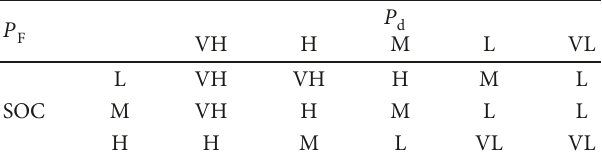
Table 2: Rule base of fuzzy logical